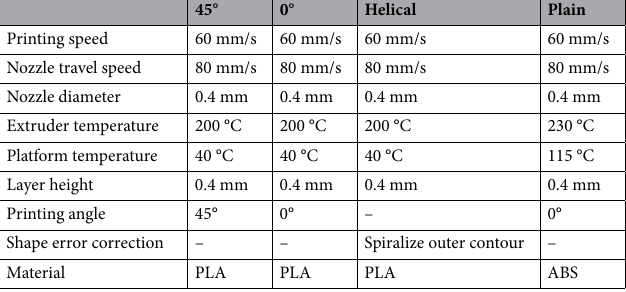
Table 1. Printing conditions and parameters of 3D printer used in this